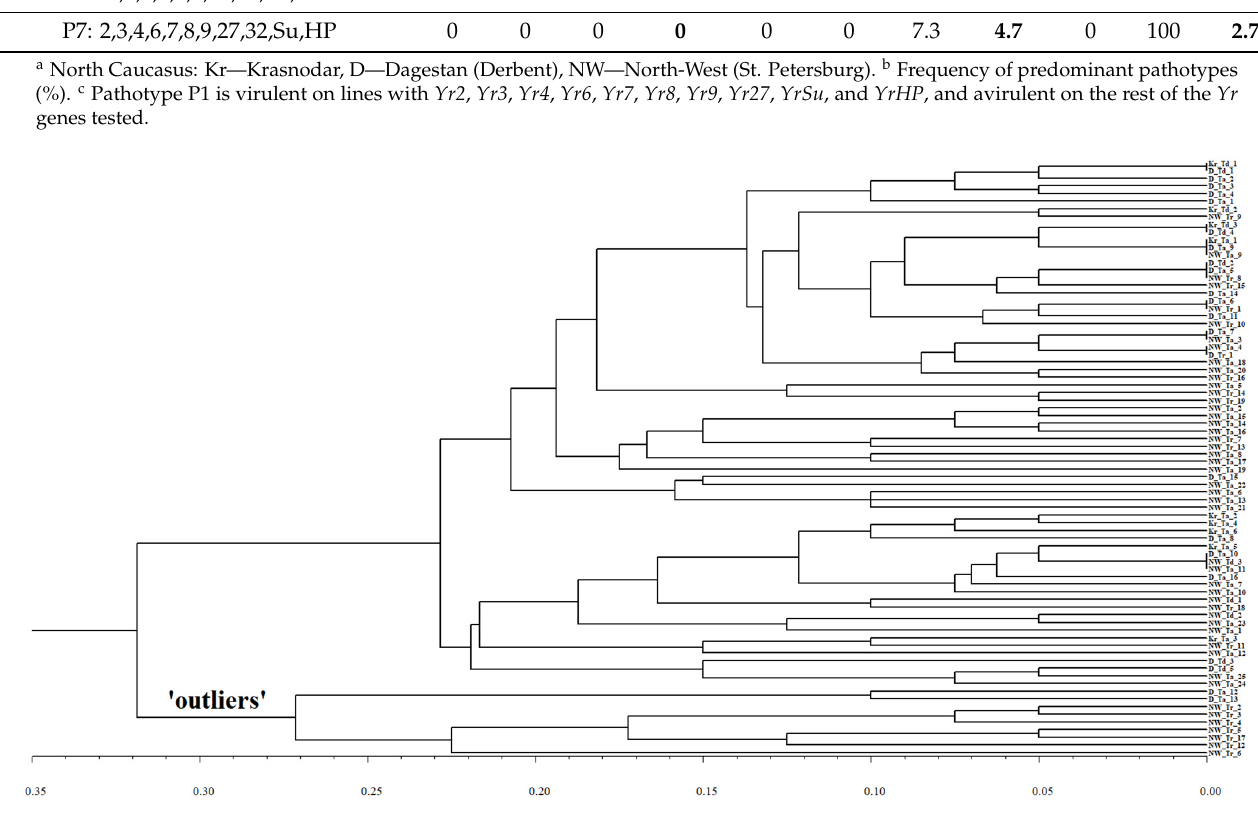
Figure 1. UPGMA dendrogram of relationships among P. striiformis pathotypes based on the simple mismatch dissimilarity between them. Abbreviations of regions and host species: D—Dagestan; Kr—Krasnodar; NW—North-West; Ta—T. aestivum; Td— T. durum ; Tr—triticale. For example, pathotype designation Kr_Td_1 means that this pathotype is number 1 from T. durum in the Krasnodar region. Group of ‘outliers’ is indicated.